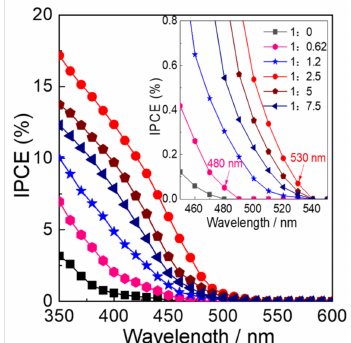
Figure 10. Action spectra of IPCE of the (black) WO 3 − 0, (pink) WO 3 − 0.62, (blue) WO 3 − 1.2, (red)